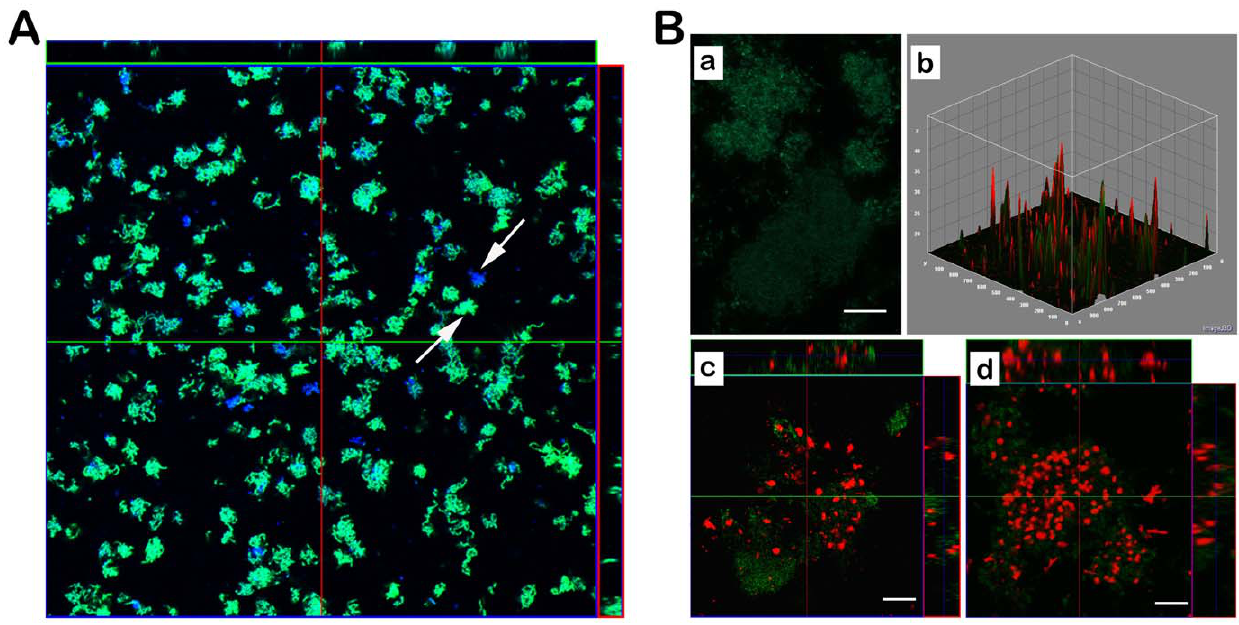
Figure 4. Signals of the pHluorin-SpaP fusion protein and metabolic activities of S.mutans in biofilms after addition of sucrose. (A) CLSM image showing pH heterogeneity of different microcolonies (indicated by arrows) within S. mutans biofilm in the presence of sucrose. Biofilms were revealed with CellTracker Orange. CellTracker Orange (blue), GFP (green) and the corresponding overly images are shown. (B) CLSM images showing differences in metabolic activities of microcolonies within S. mutans biofilm after addition of sucrose. (a) CLSM analysis of pHluorin signals of S. mutans strain O87 biofilm after addition of 2% sucrose for 60 min. Bars represent 50 m m. (b) 3D surface plot of fluorescence intensities of pHluorin (green) and the fluorescent metabolic indicator dye 5-Cyano-2,3-ditolyl tetrazolium chloride (CTC - red) in strain O87 biofilm after addition of 2%